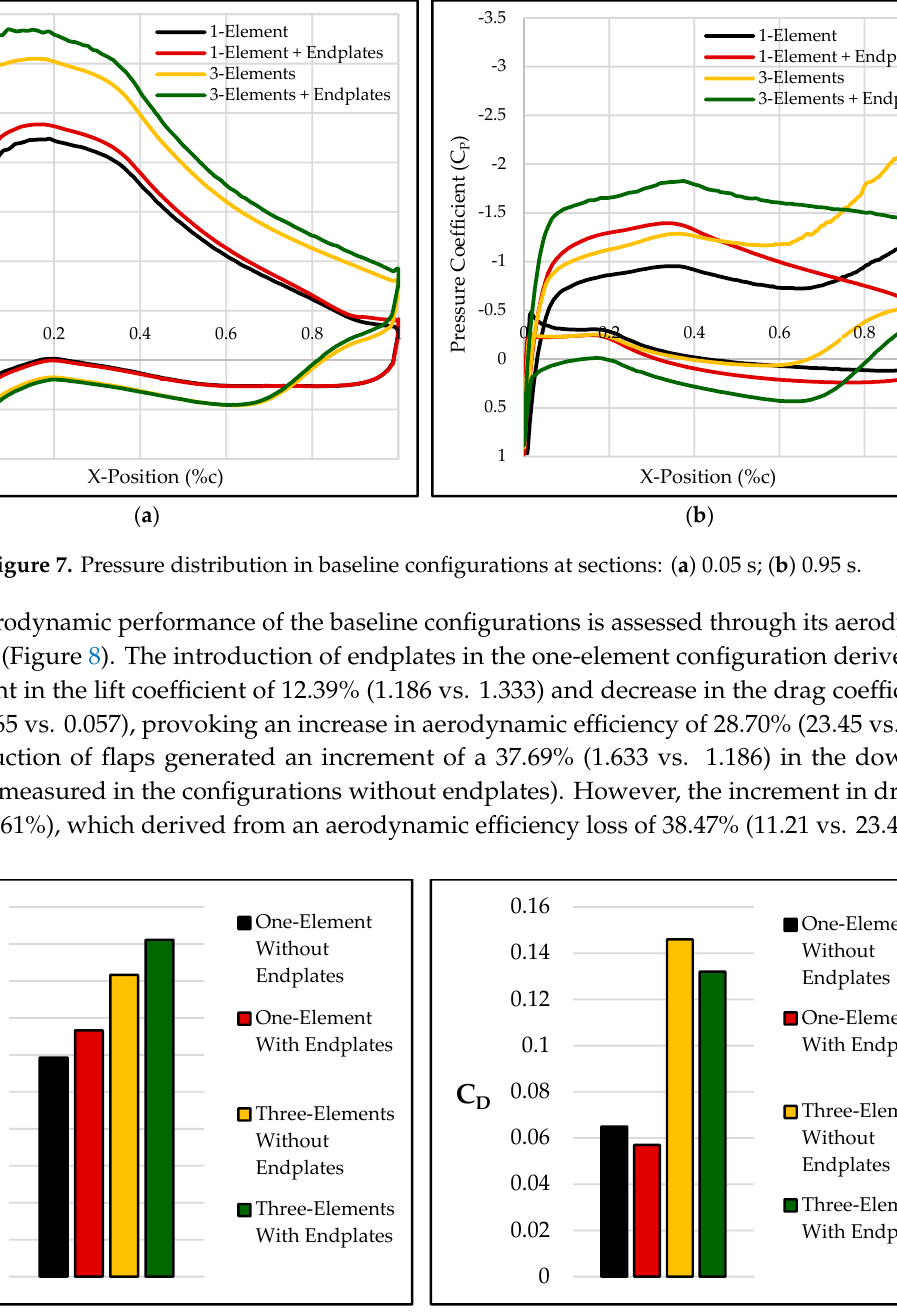
Figure 8. ( a ) Lift coefficients; ( b ) Drag coefficients.